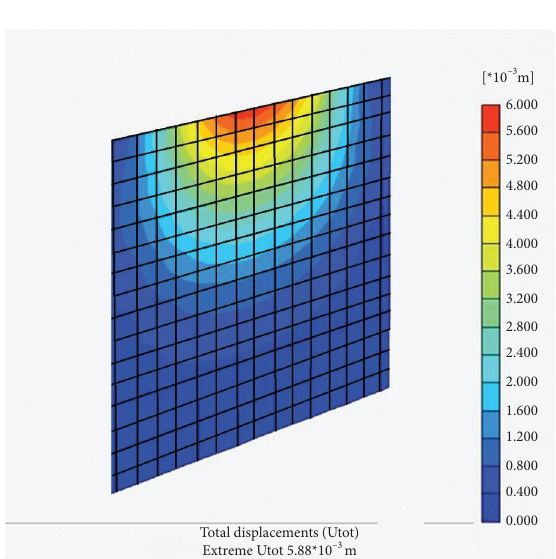
Figure 17: Maximum deformation point of a sheet